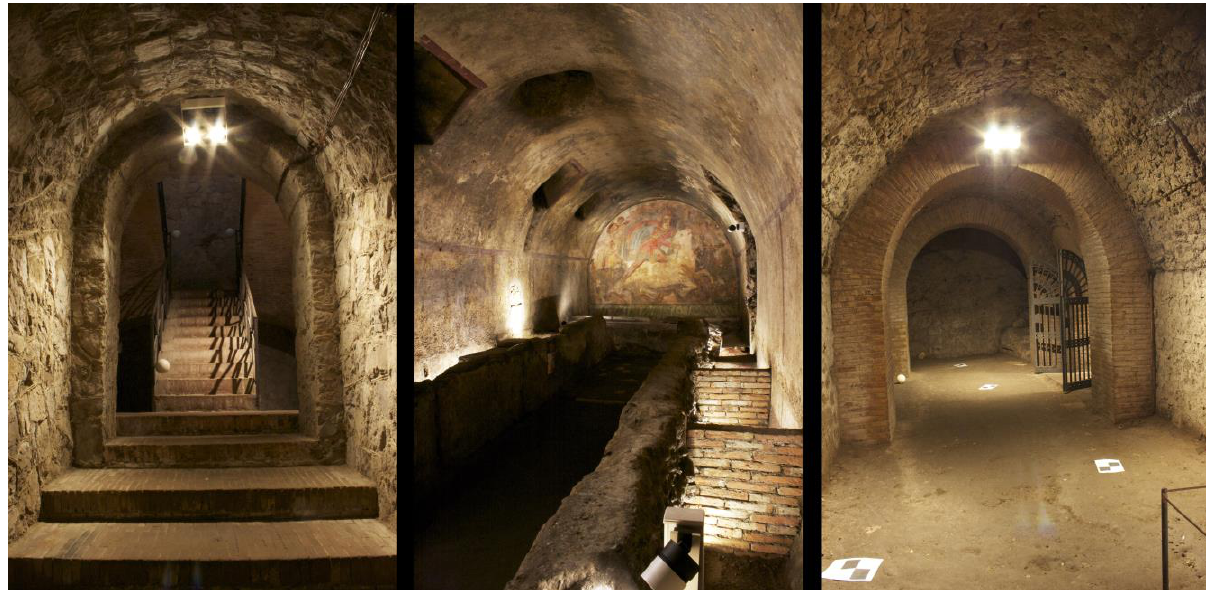
Figure 1. Mithraeum of Santa Maria Capua